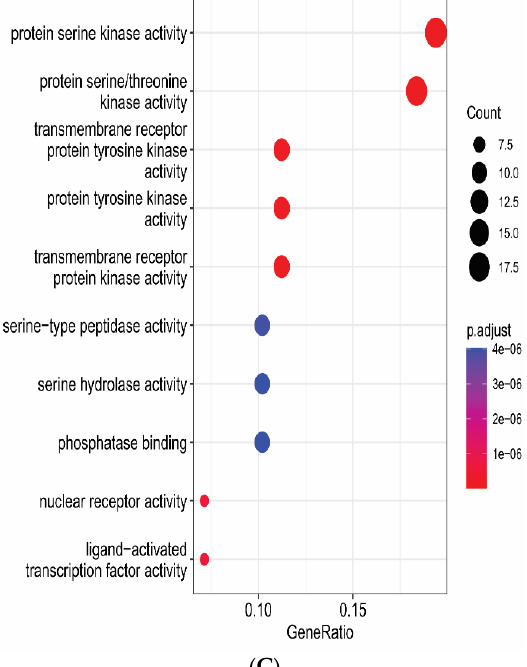
Figure 6. GO analysis of C. fistula ’s potential targets on EOC. ( A ) Biological Processes (BP), ( B ) Cellular Components (CC), and ( C ) Molecular Functions (MF).